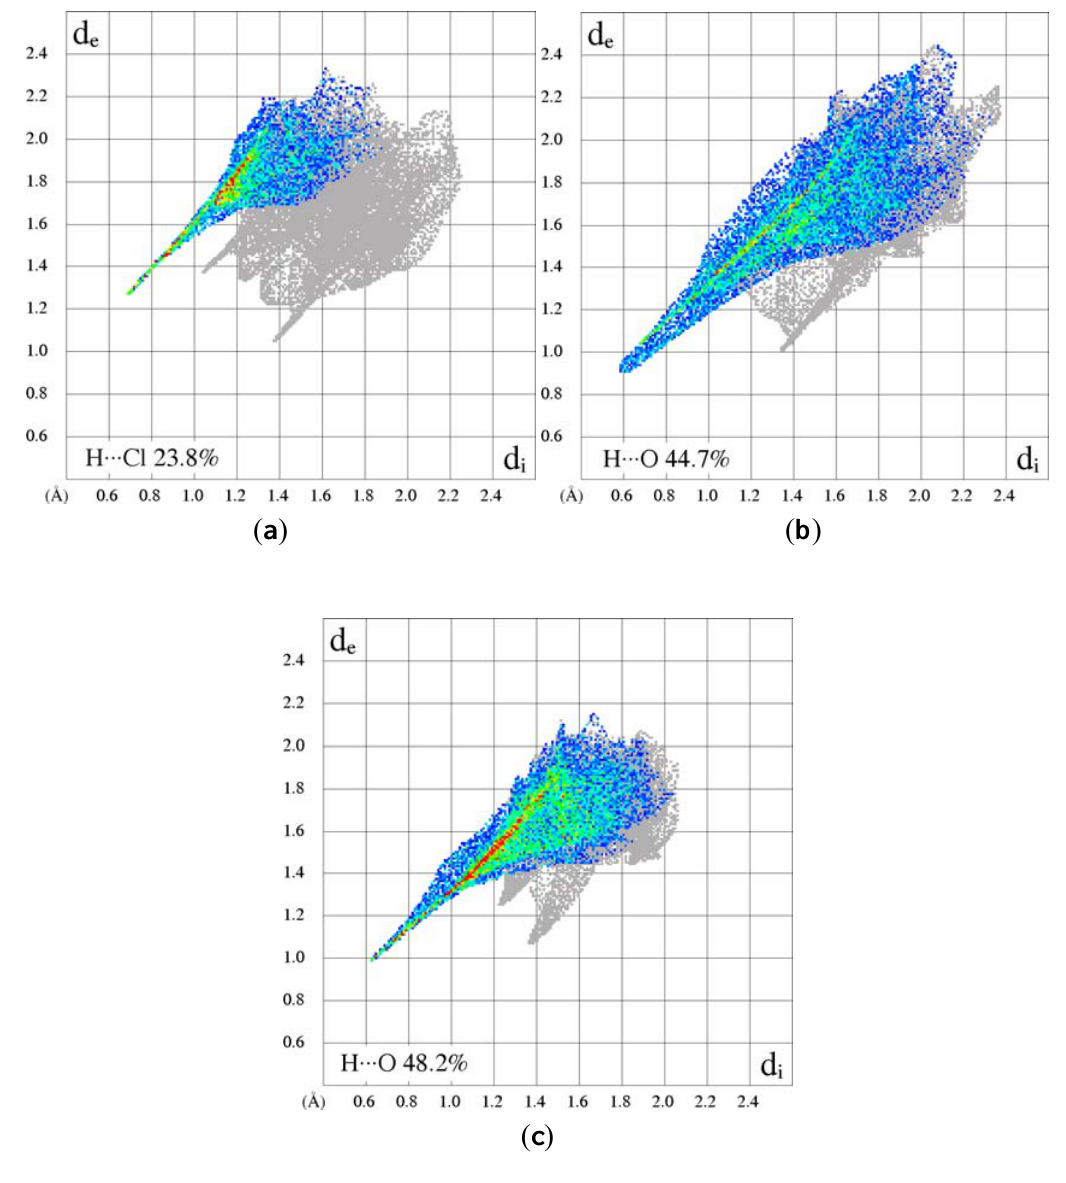
Table 3. Percent contributions of selected interactions relative to the whole Hirshfeld surface. Independent cations are termed A and B. Only major interactions are